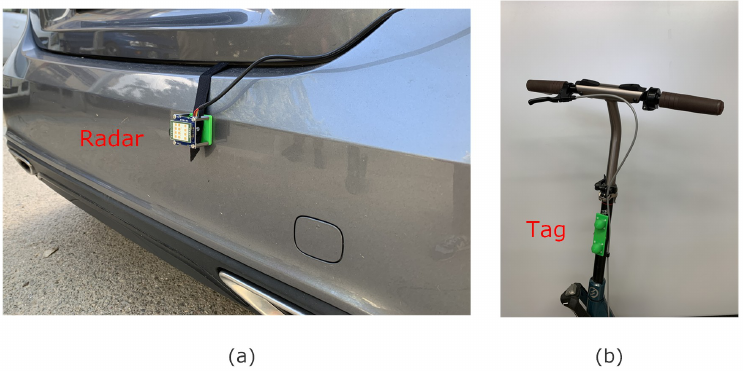
Figure 22. ( a ) Photograph of the radar installed at the rear of the car; ( b ) tag installed on the scooter.